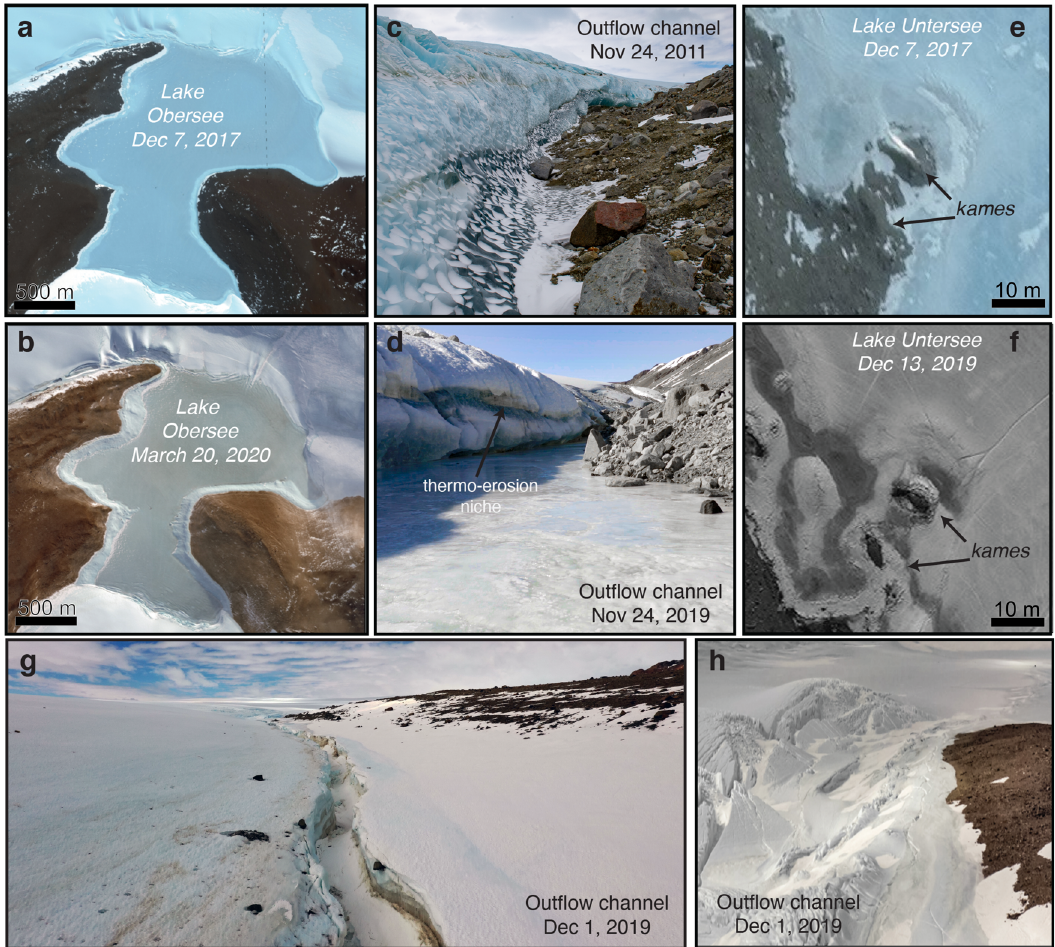
Fig. 5 Glacial lake outburst fl ood-related features in the Untersee Oasis. a Extent of Lake Obersee (December 7th, 2017). ©2020 Digital Globe NextView. b Extent of Lake Obersee (March 20th, 2020). ©2020 Digital Globe NextView. c Ancient out fl ow channel on the Anuchin Glacier ’ s East lateral moraine (photo taken in Nov. 2011). The width of the reddish boulder in the central portion of the image is ~1 m. d thermally eroded out fl ow channel (~5 m in width) on the Anuchin Glacier ’ s East lateral (photo taken in Nov. 2019). e Extent of ice coverage on two Kames on the North-East side of Lake Untersee ’ s push moraine before the GLOF event (December 7th, 2017). ©2020 Digital Globe NextView. f Extent of ice coverage on two Kames on the North-East side of Lake Untersee ’ s push moraine after the 2019 GLOF event (December 7th, 2017). ©2020 Digital Globe NextView. g Thermally eroded out fl ow channel (~4 m in width) at the North-East extremity of the Anuchin Glacier (image taken in Dec. 2019). h Out fl ow channel at the North-West extremity of Lake Obersee (photograph taken on December 5th, 2019). Width of the crevassed ice area is ~30 m.